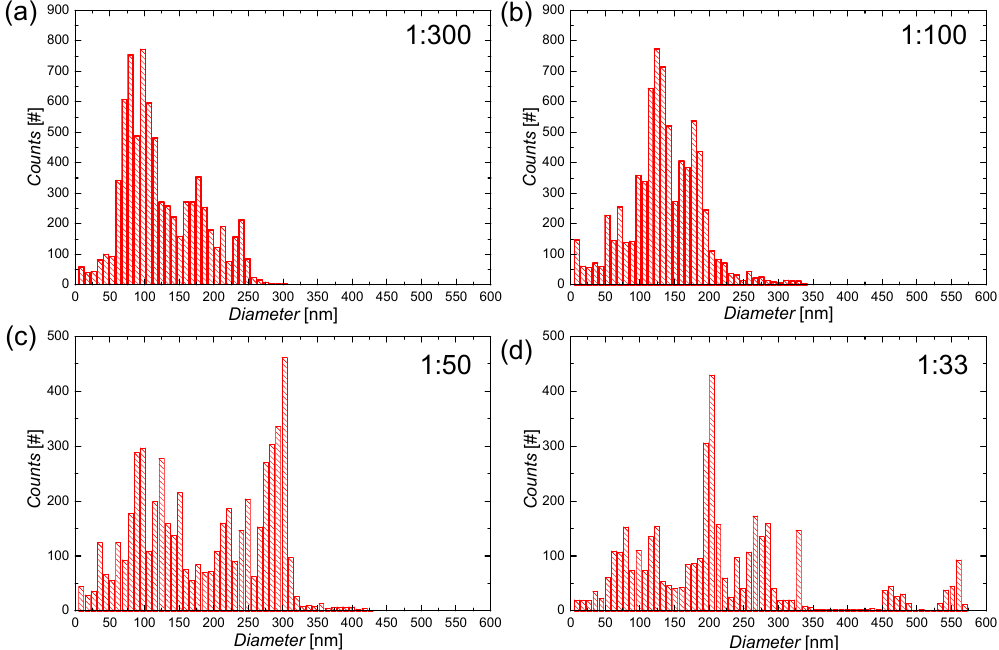
Figure A2. Diameter histograms for the precursor-to-solvent series with different mass ratios (precursor:solvent) of ( a ) 1:300, ( b ) 1:100, ( c ) 1:50 and ( d ) 1:33.